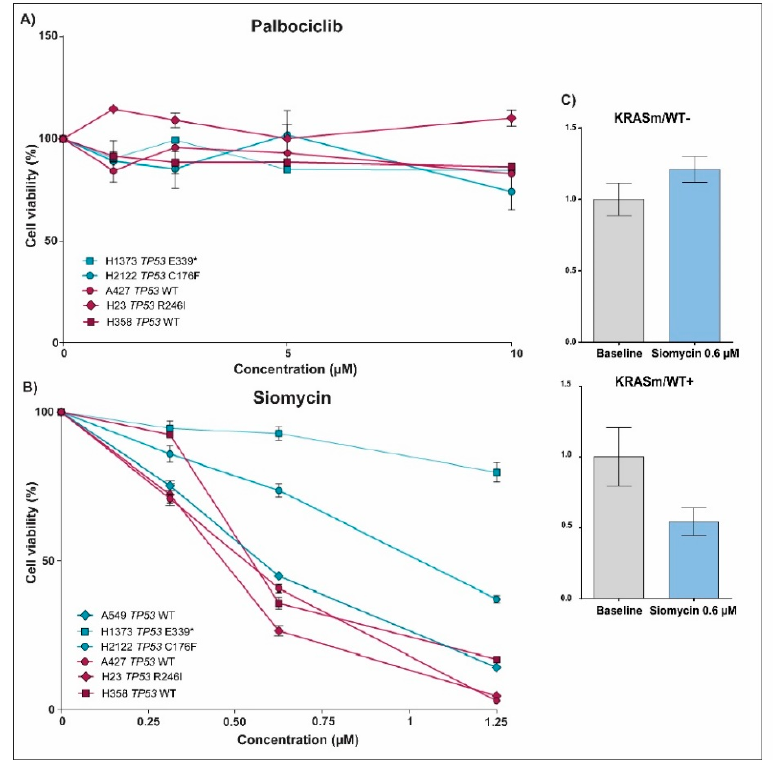
Figure 6. Drug sensitivity assay and changes in FoxM1 expression after treatment with Palbociclib and Siomycin in KRASm/WT+ and KRASm/WT − NSCLC cell lines. Line plots show cell viability after 72 hours of incubation with Palbociclib and Siomycin in KRASm/WT − (A549, H1373 and H2122; blue lines) and KRASm/WT+ (A427, H23 and H358; red lines) cell lines ( A and B ). Data were normalized on matched vehicle control samples, namely PBS and DMSO for Palbociclib and Siomycin, respectively. Changes in FoxM1 phosphorylation levels after 72 hours of incubation with 0.6 μ M of Siomycin were captured in KRASm/WT+ and KRASm/WT − lines using the RPPA ( C ). * Indicates stop codon.